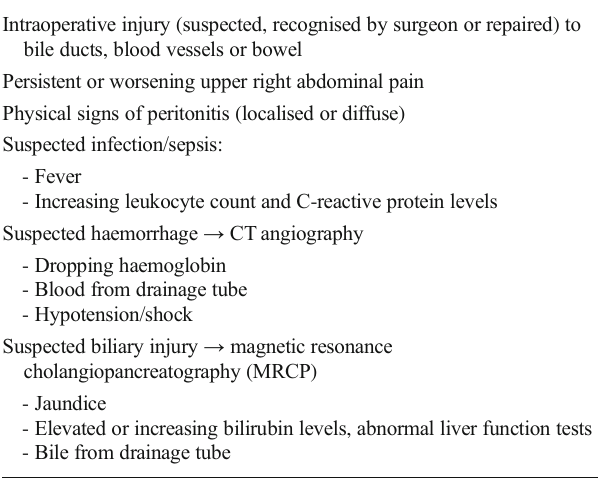
Clinical indications for early post-cholecystectomy cross-sec- tional imaging Intraoperative injury (suspected, recognised by surgeon or repaired) to bile ducts, blood vessels or bowel Persistent or worsening upper right abdominal pain Physical signs of peritonitis (localised or diffuse) Suspected